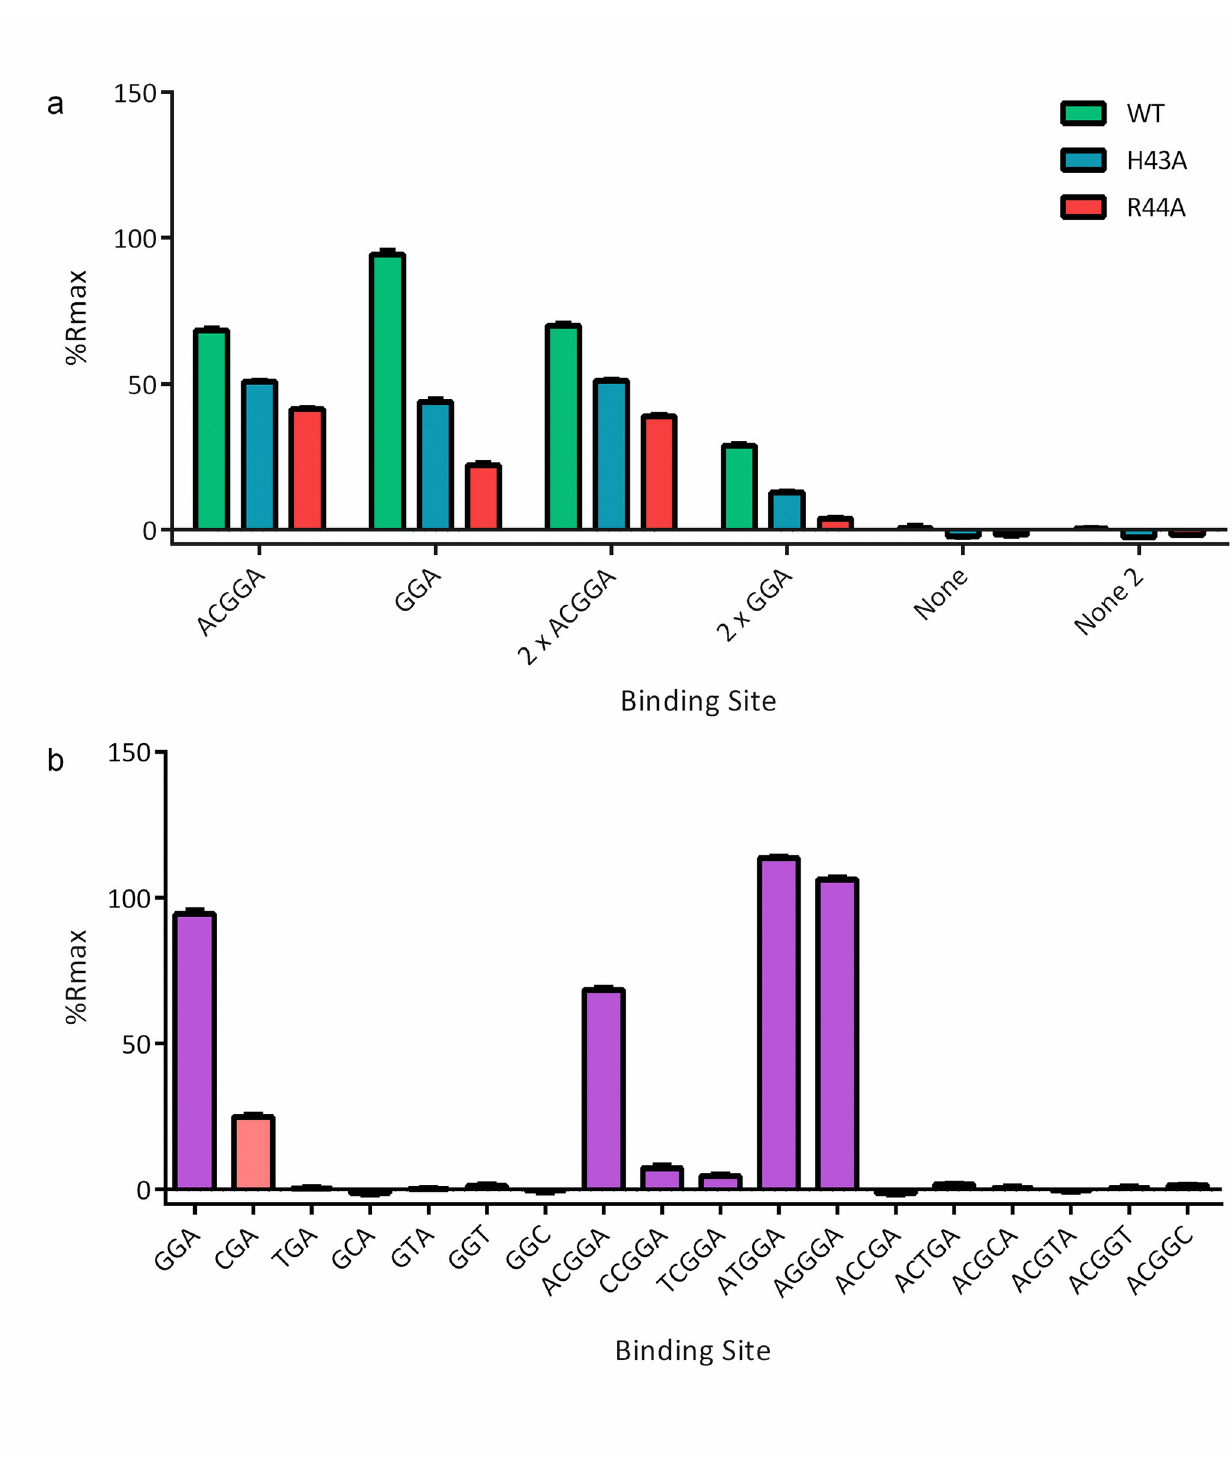
Fig 2. RsmQ interacts with its preferred binding sequence (GGA/AnGGA) and this interaction is mediated by the VHRE/D binding site. (a) Percentage R max values for RsmQ WT (green) H43A (blue) and R44A (red) binding to ssDNA containing the binding sites shown above. Two-way ANOVA showed an effect of both binding site ( p < 0.0001) and mutation ( p < 0.0001) on R max . (b) Percentage R max values for WT RsmQ binding to ssDNAs containing the above binding site. Binding sites that are predicted to bind RsmQ are shown in purple. All oligos are designed as hairpins and results shown are for RsmQ at a concentration of 100 nM. Error bars represent the standard deviation of 2 replicates. Data are available in S1 Data. ssDNA, single-stranded DNA; WT,